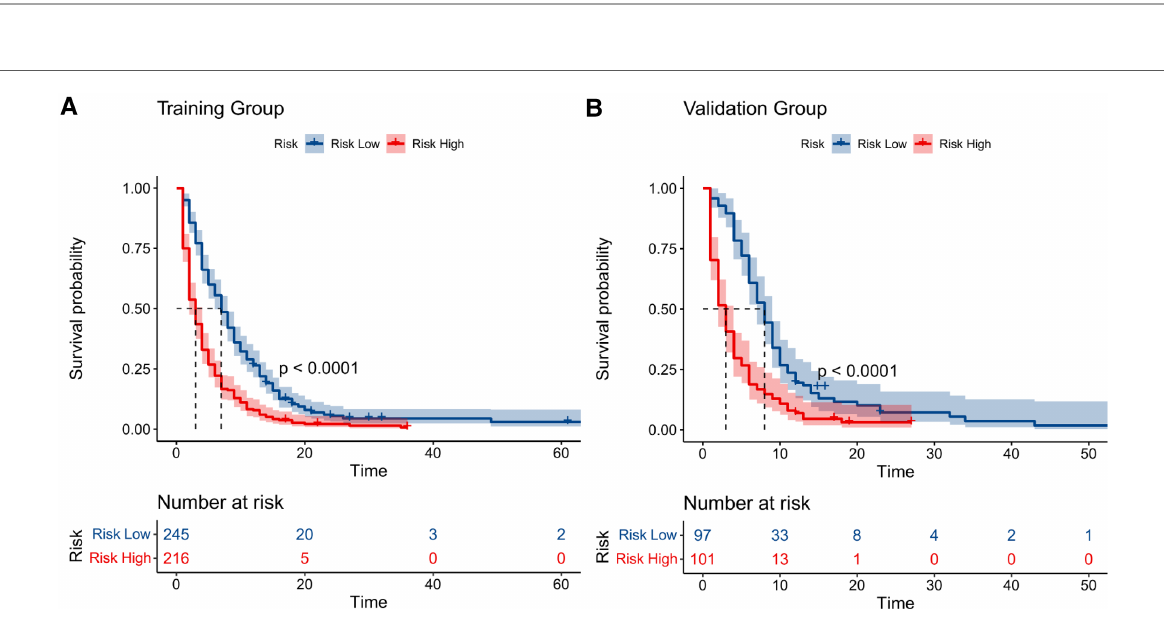
FIGURE 10 Kaplan – meier curves of high- and low-risk patients in the training group ( A ) and validation group ( B ). Patients in the low-risk group had a higher survival probability than those in the high-risk group ( P <0.0001) in both cohorts.